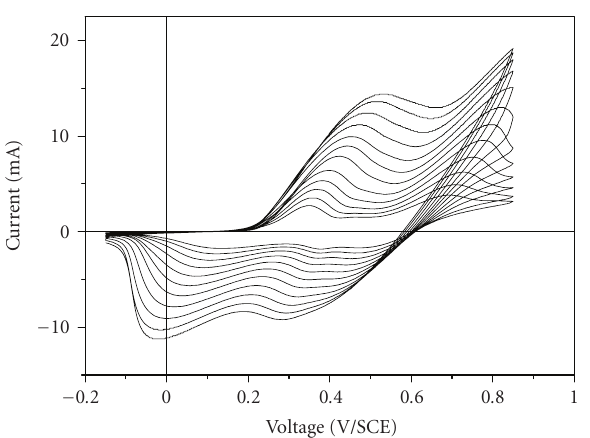
Figure 2: Cyclic voltammogram recorded during the synthesis of POT films in an aqueous solution of HCl.